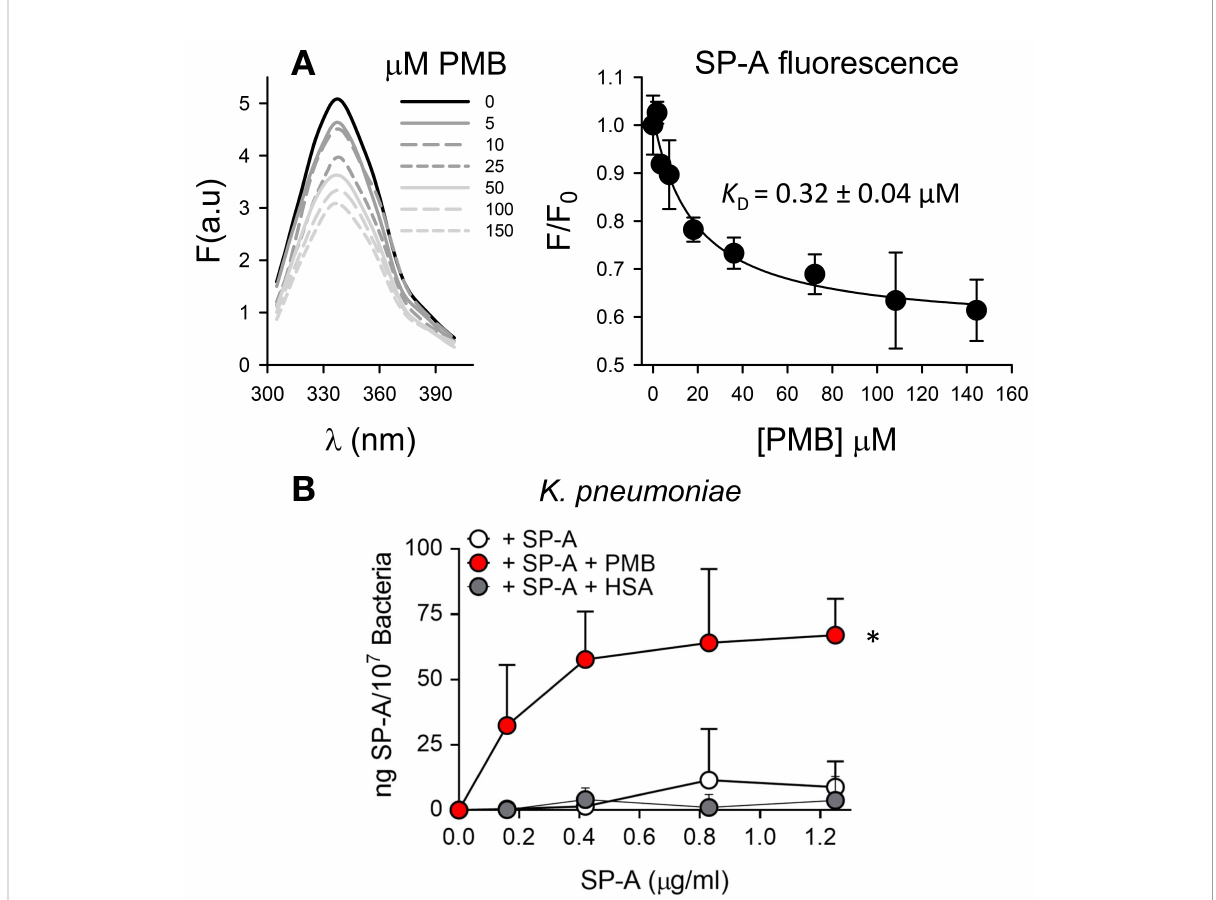
FIGURE 4 SP-A and polymyxin B interact in a dose-dependent manner, allowing binding of SP-A to K pneumoniae . (A) (Left) Tryptophan fl uorescence emission spectra of SP-A (15 nM) (10 m g/ml) were measured with or without increasing concentrations of PMB (0-150 m M; 0-180 m g/ml) at 25°C in 5 mM Tris-HCl buffer (pH 7.4) containing 150 mM NaCl. SP-A samples (with and without PMB) and blank samples (PMB alone) were excited at 295 nm and the emission spectra recorded from 300 to 400 nm. One representative experiment of four is shown. (Right) Results are expressed as F/F 0 , where F and F 0 are the corrected emission intensities at 337 nm in the presence and absence of PMB. Results are means ± SD of four experiments. (B) Binding capacity of biotinylated SP-A to K pneumoniae (10 7 CFU) in the presence and absence of PMB (5 m g/ml) or HSA (5 m g/ ml). The concentration of biotinylated SP-A associated with K pneumoniae was measured by a solid phase binding assay. Data are means ± SD of three independent experiments with three biological replicates. A value of * p < 0.05 was obtained for the one-way